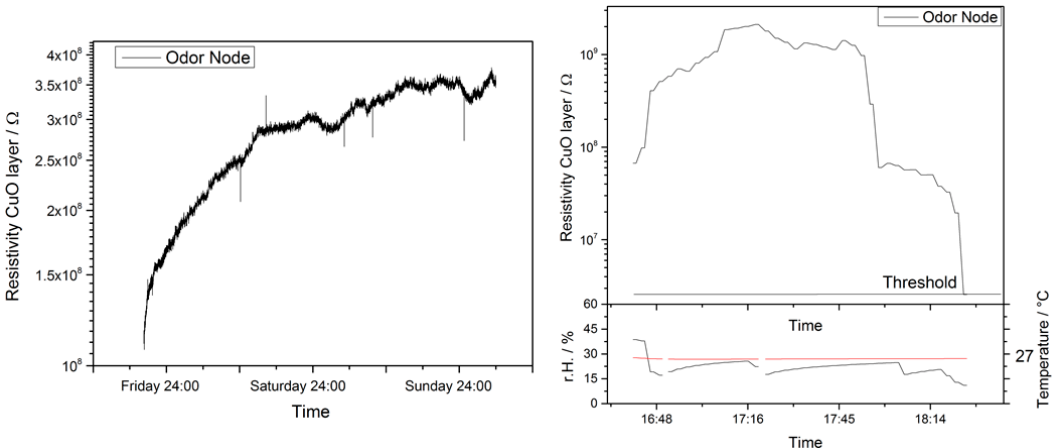
Figure 3. Sample measurement of a single odor sensing node in the sleep mode, i.e., at ambient temperature: The state of the gas sensitive layer has been checked every minute for several days and no odor event has been detected. The resistivity value varies due to ambient temperature and humidity changes. To simulate an odor event occurring we did expose the device to low levels of hydrogen sulphide of about 1 ppm. The steep decline of the resistivity below a threshold value triggers the odor detection